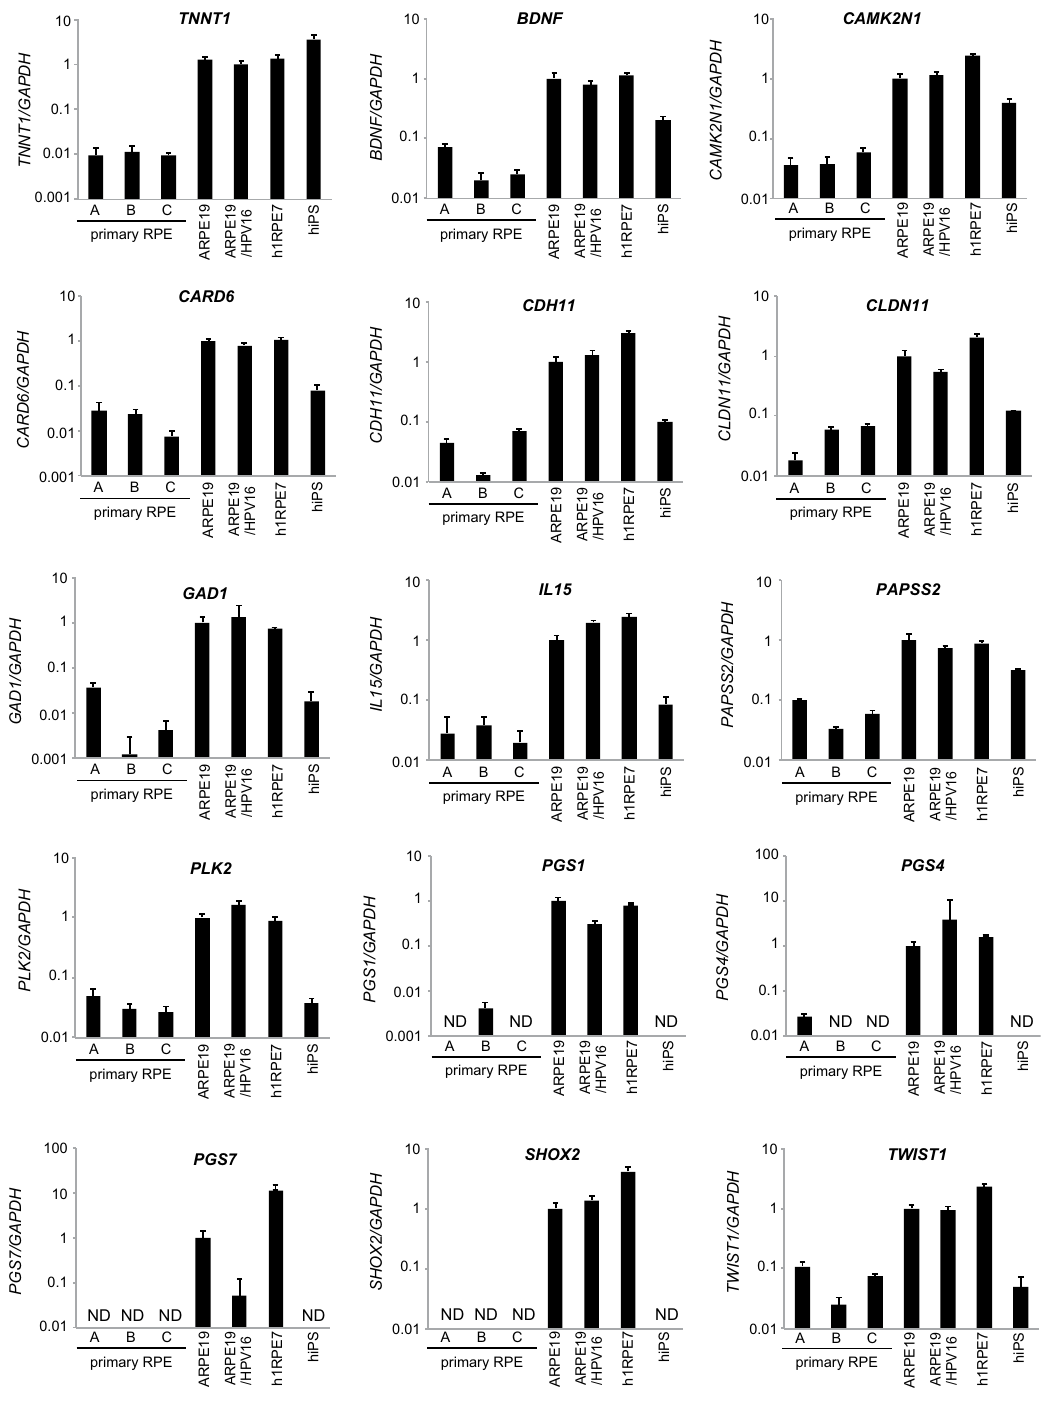
Figure 2. Identification of immortalized RPE cell marker genes. qRT-PCR analysis of immortalized RPE cell marker candidate genes in primary RPE cells, immortalized RPE cells, and hiPSCs. Bar graph represents fold gene expression relative to ARPE-19 cells. Results are means ± standard deviations (n = 5). N.D.: not